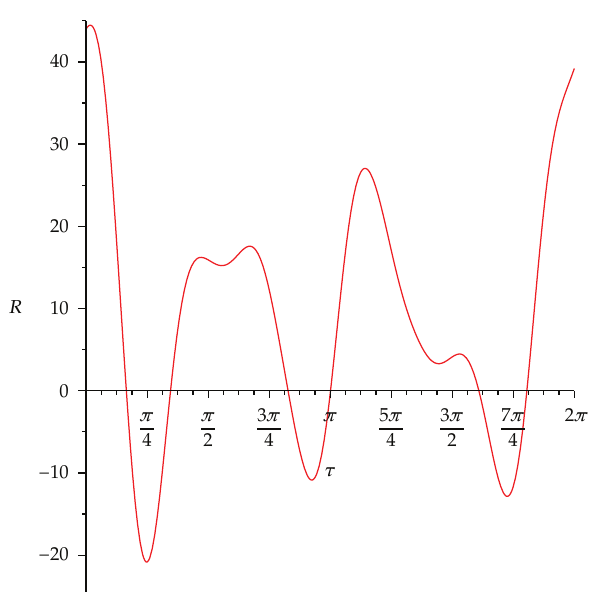
Figure 22: The evolution of the R with respect of the cosmic time τ for (cid:2) 4.19 (cid:3)